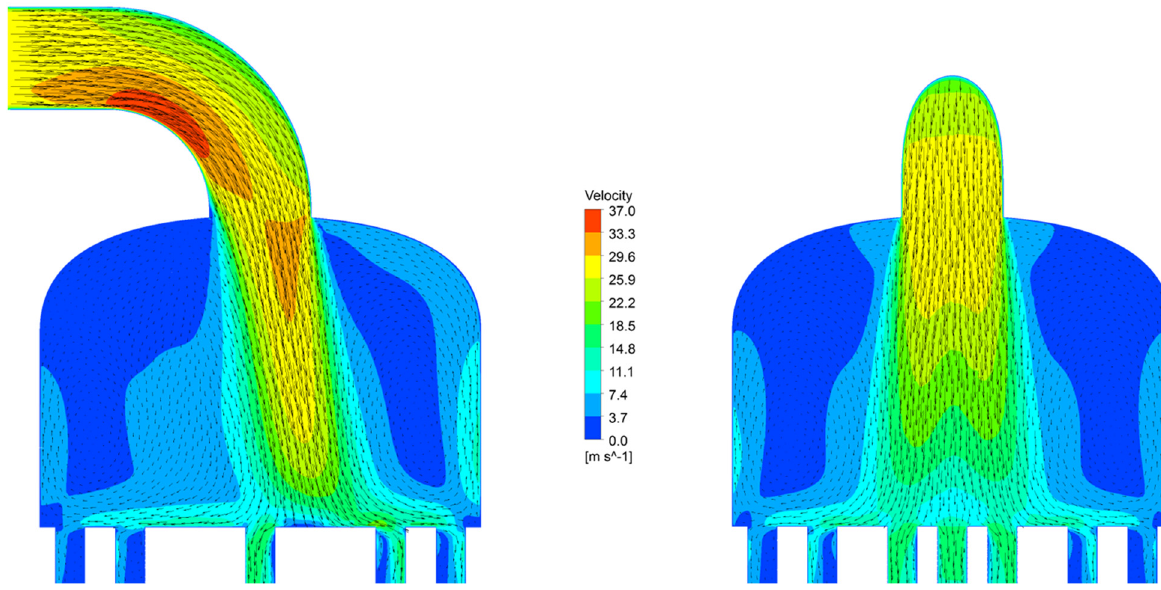
Figure 4. Syngas velocity distribution within the intake header for the clean heat exchanger.